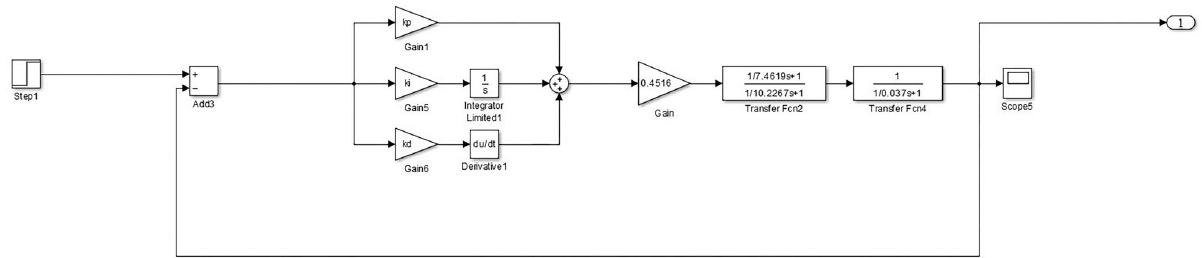
Fig 14. Simulink simulation of genetic PID control for warp